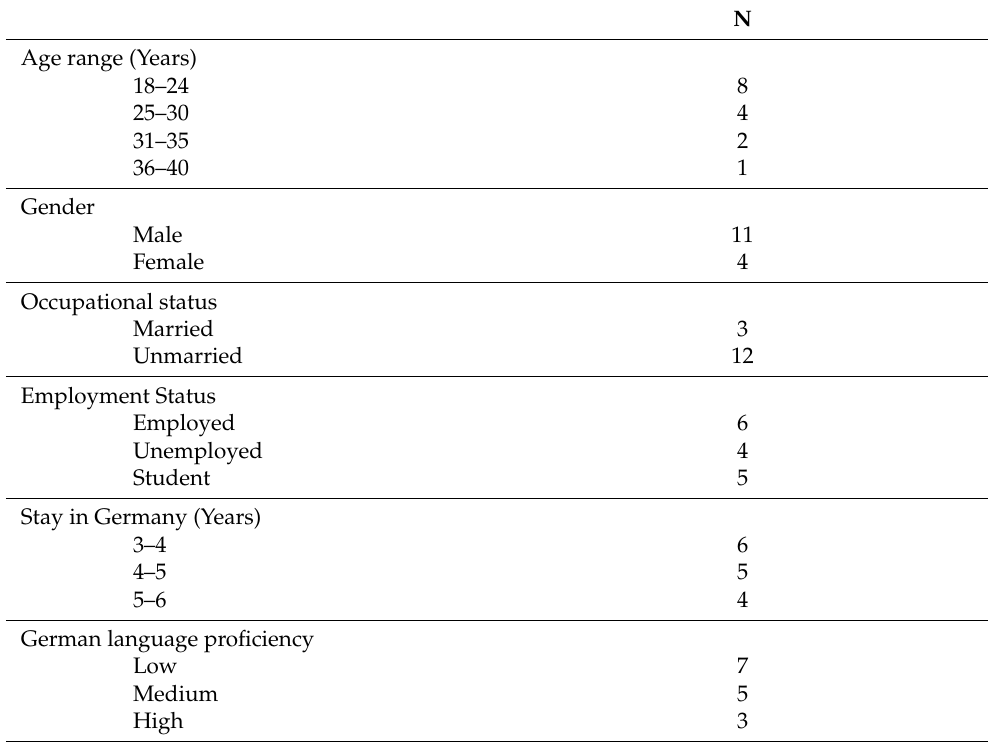
Table 1. Demographic characteristics of